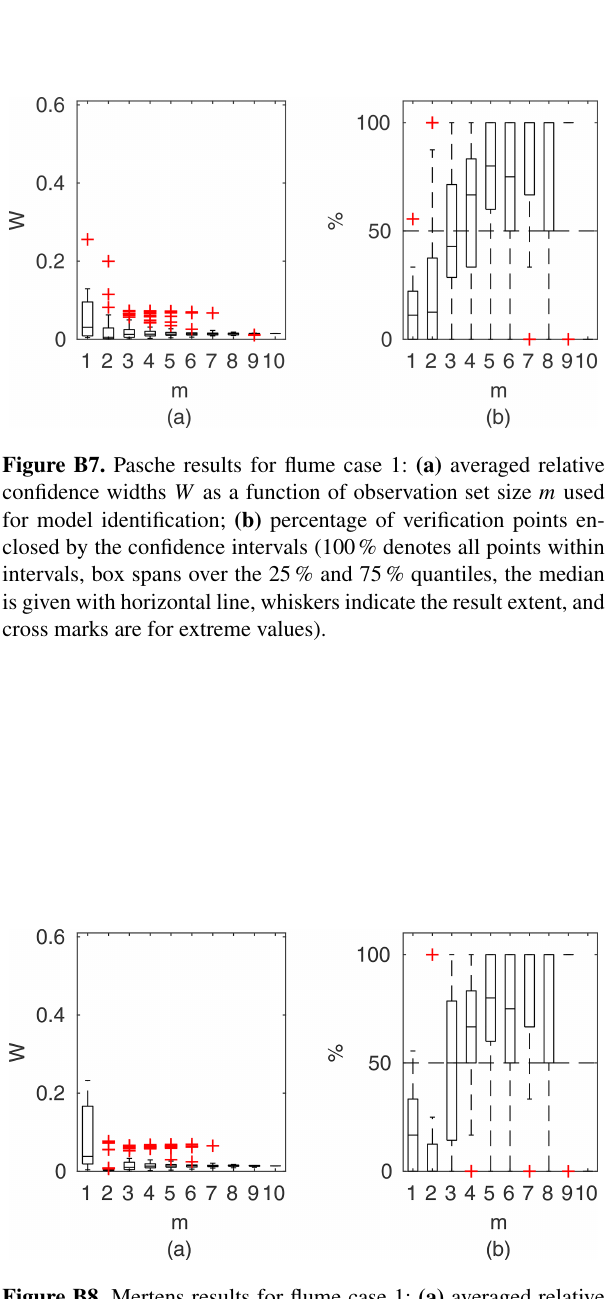
Figure B6. DCM Manning results for flume case 1: (a) aver- aged relative confidence widths W as a function of observation set size m used for model identification; (b) percentage of verifi- cation points enclosed by the confidence intervals (100% denotes all points within intervals, box spans over the 25% and 75% quan- tiles, the median is given with horizontal line, whiskers indicate the result extent, and cross marks are for extreme values).